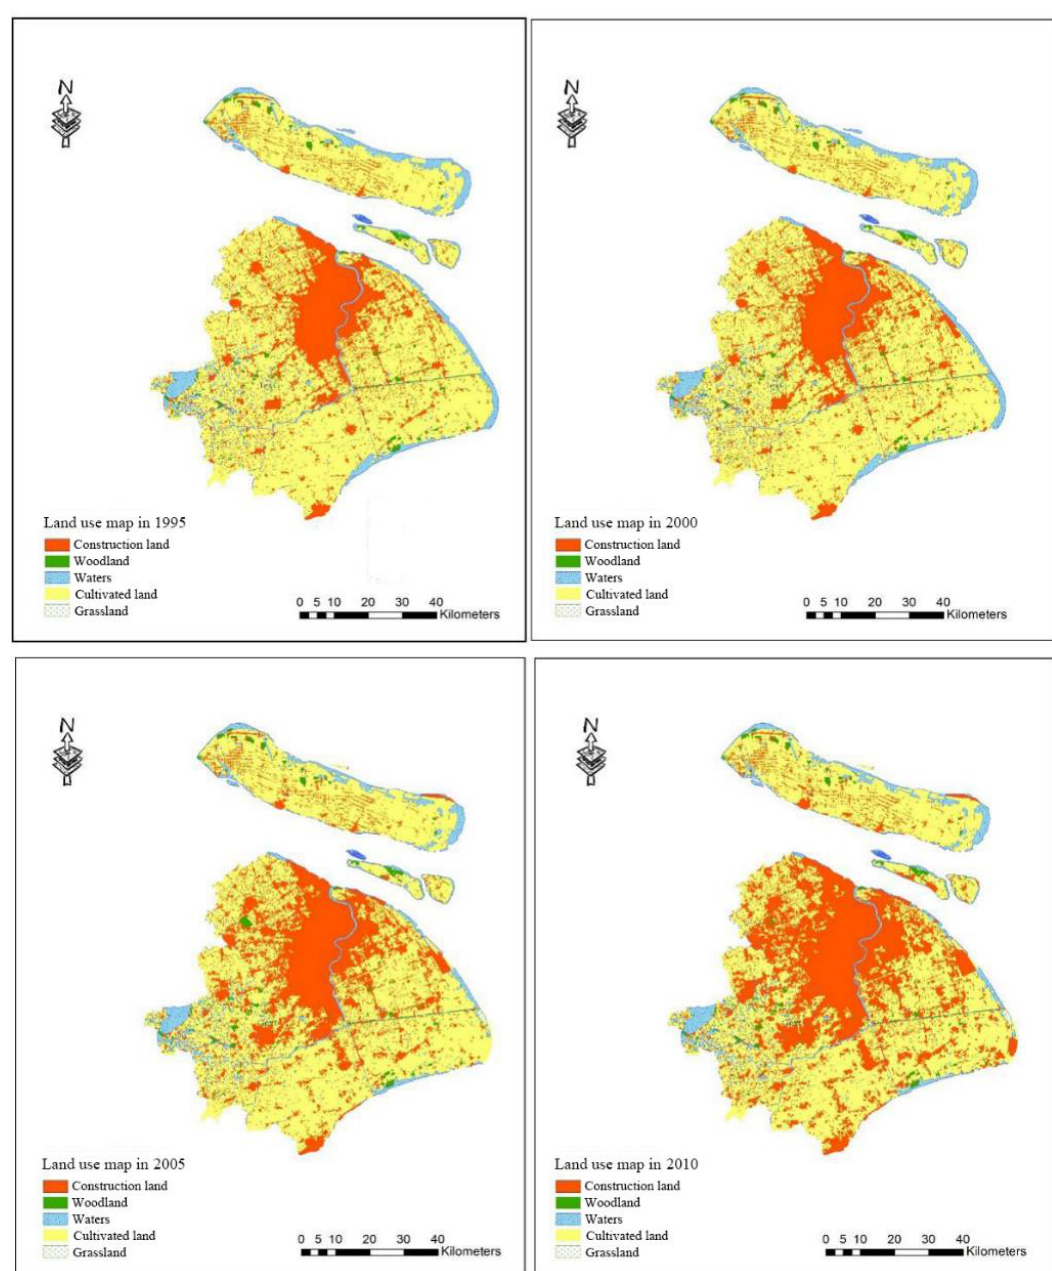
Figure 2. Land use maps of Shanghai in 1995 , 2000 , 2005 and 2010. Table 1. Introduction of Landsat Thematic Mapper (TM).